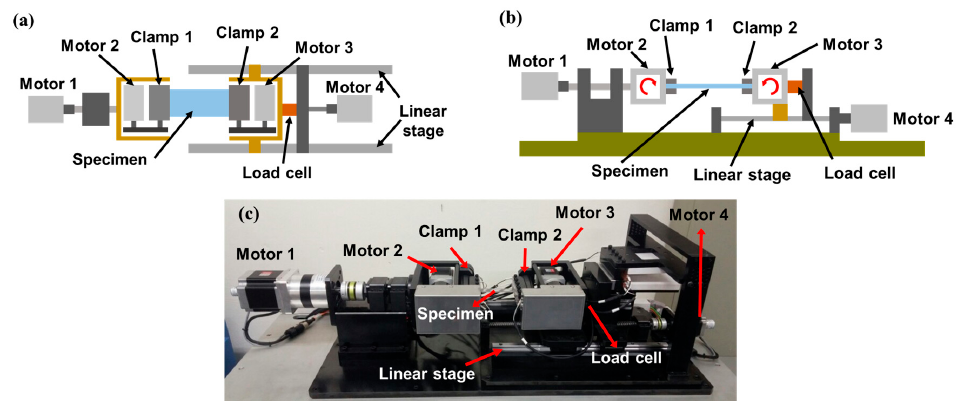
Figure 2. Developed universal test apparatus ( a ) schematic top view; ( b ) schematic side view; ( c ) actual photograph.